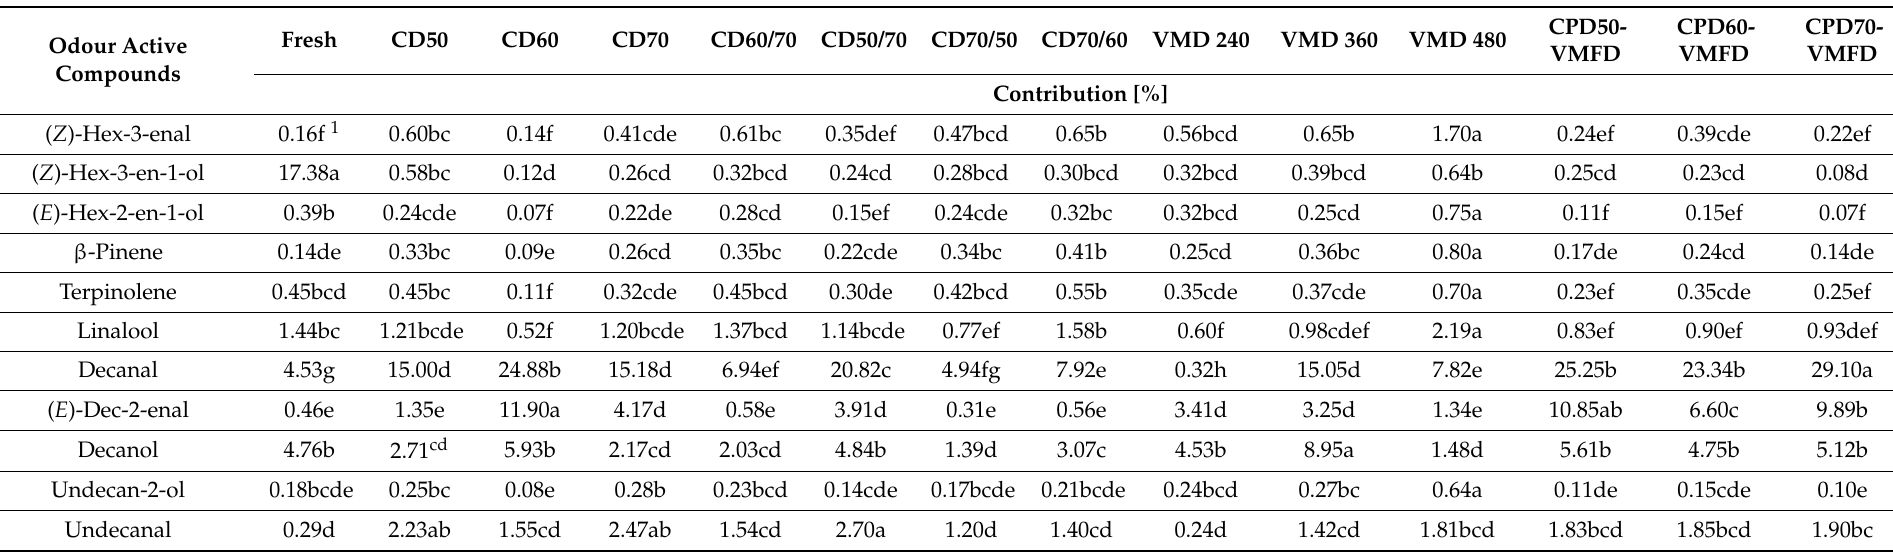
Table 4. Contribution of particular cilantro OACs in fresh cilantro and samples subjected to